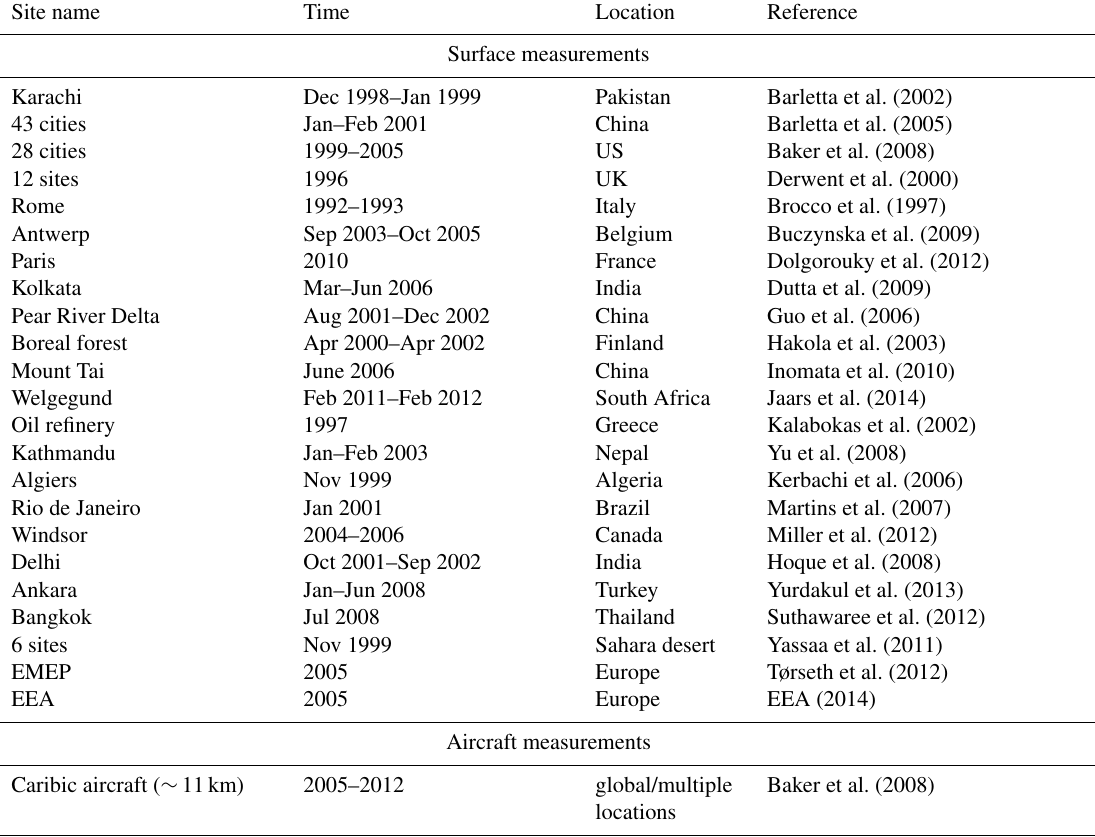
Table 1. Aircraft and surface measurements of aromatics that are used for comparison with model